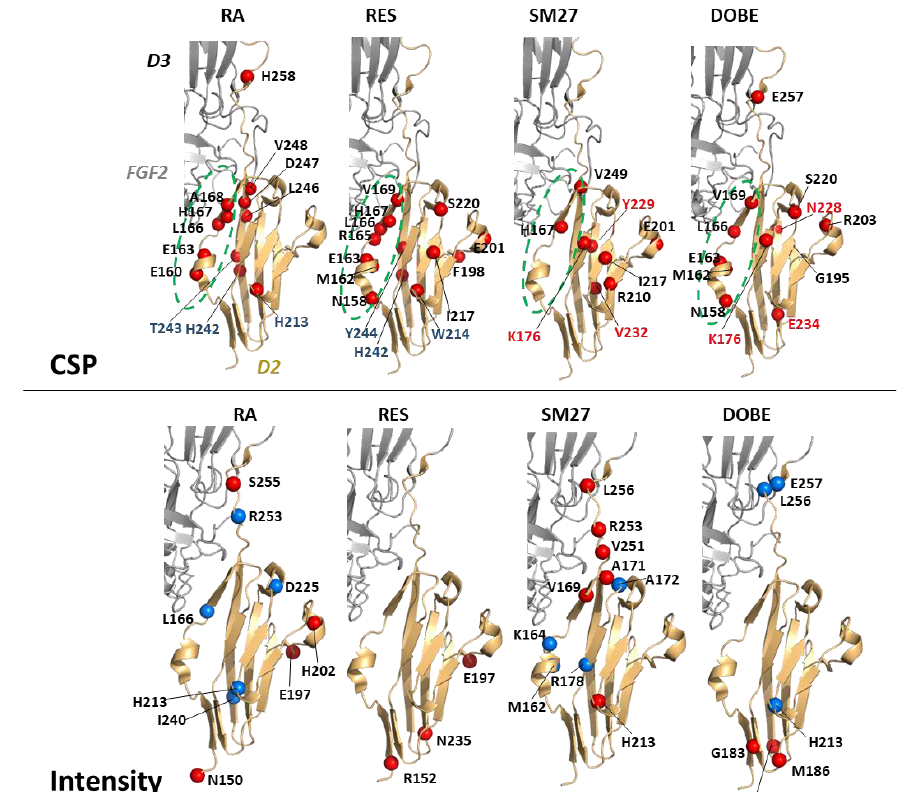
Figure 6. Upon ligand addition, chemical shift variations of D2 amide resonances higher than ⟨ CSP ⟩ + 1 σ are reported on the D2 structure as red spheres (upper panels). Intensity changes lower than − (<|I − I − I σ ) and higher than +(<|I σ ) are shown as blue and red D2 |> + 2 D2 |> + 2 D2:ligand D2:ligand spheres, respectively (lower panels). FGF2 and D3 are represented as grey cartoonfor clarity. The employed PDB structures are reported in Material and